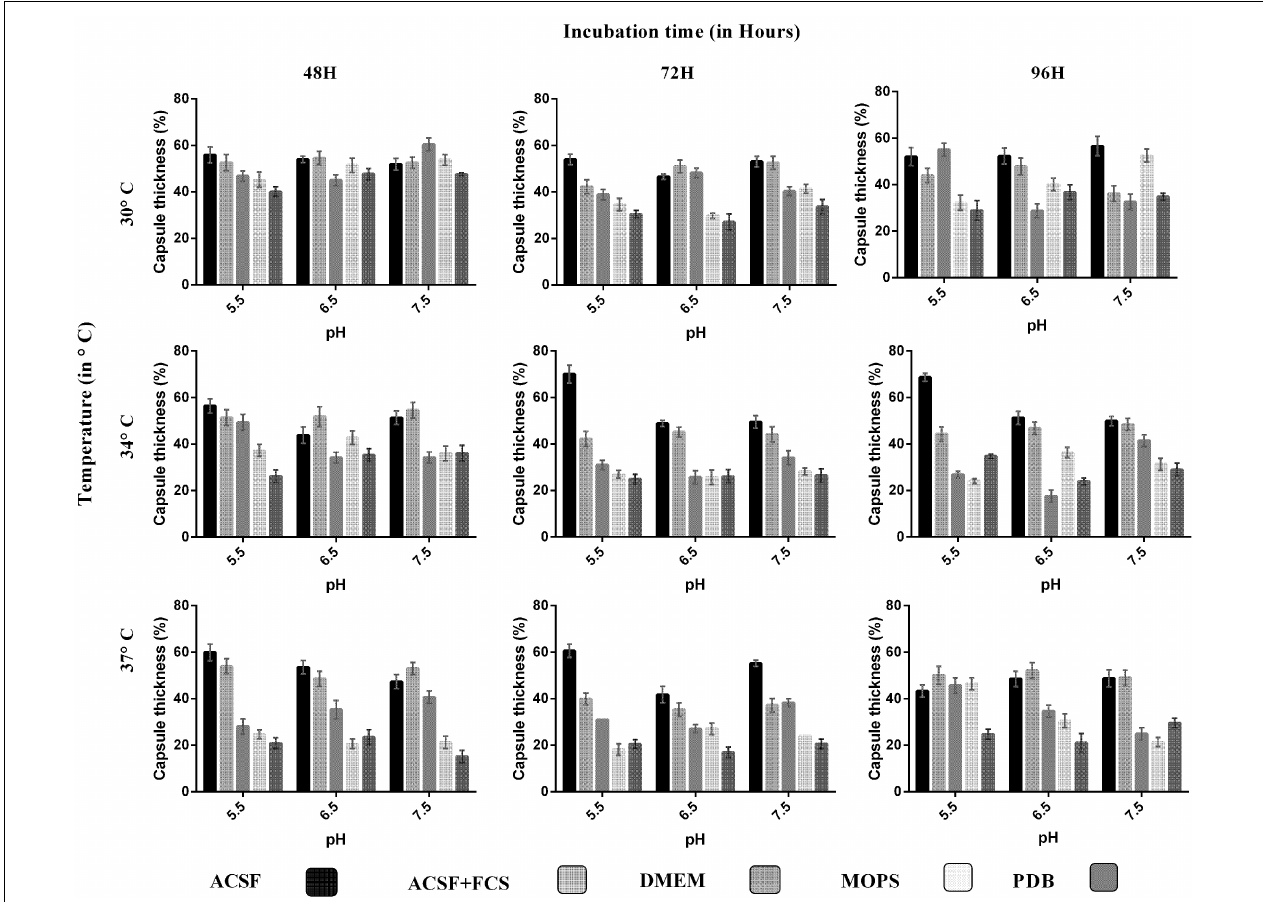
FIGURE 1 | Comparison of capsule induction in ATCC C. neoformans in different media (ACSF, ACSF + FCS, DMEM, MOPS, and PDB) at various pH, temperature, and incubation period. The percentage of the capsule thickness [(total size ∗ – cell size)/(total size ∗ ) × 100] for ≥ 8 cells per group is shown. Bars represent standard errors ( p < 0.0001). The greater capsule growth was observed in ACSF media (70%) at pH 5.5, 37 ◦ C, 72 h, followed by DMEM 60%, ACSF + FCS 55%, MOPS 53%, and PDB 47%. ∗ Total size = capsule size + cell size.